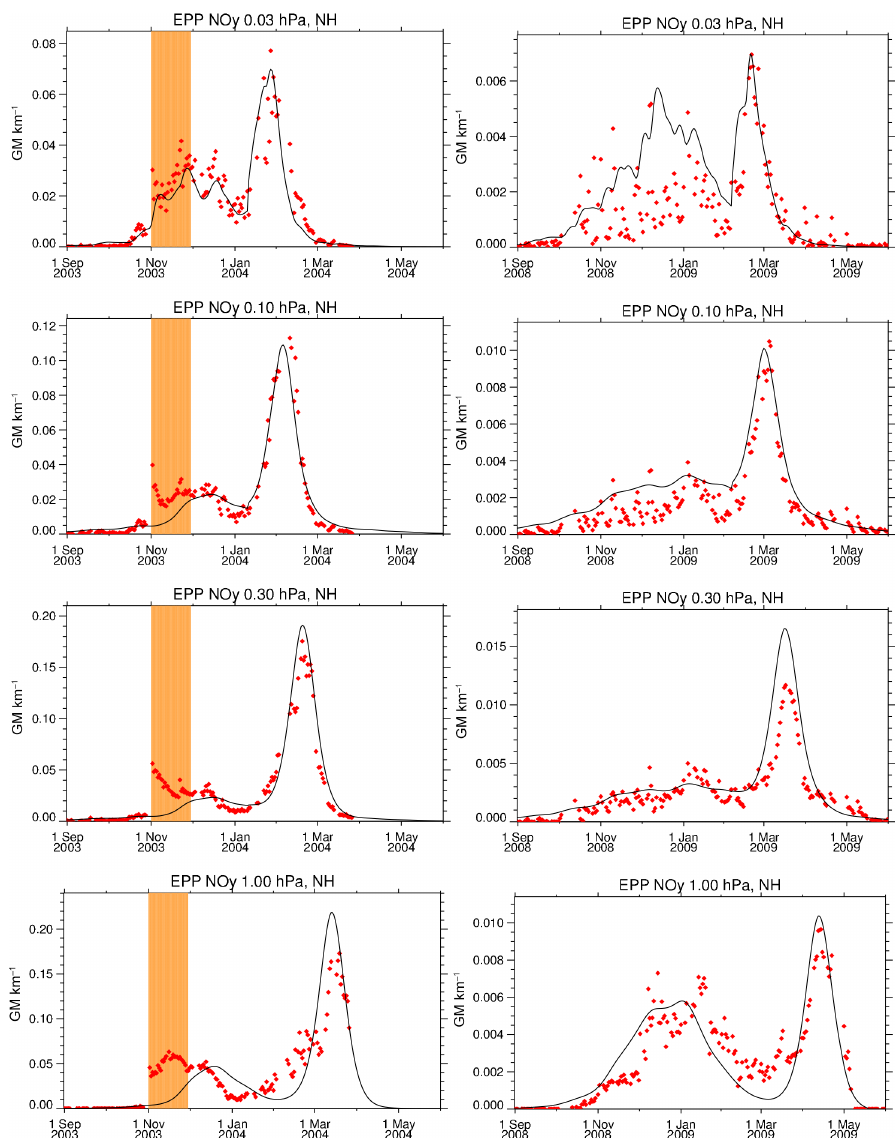
Figure 8. Observed (red diamonds) and modeled (solid black) temporal evolution of NH EPP-NO y amounts during ES winters 2004 (left) and 2009 (right) at pressure levels 0.03, 0.1, 0.3, and 1hPa (top to bottom). The orange-shaded area indicates the period affected by the large SPE event of October/November